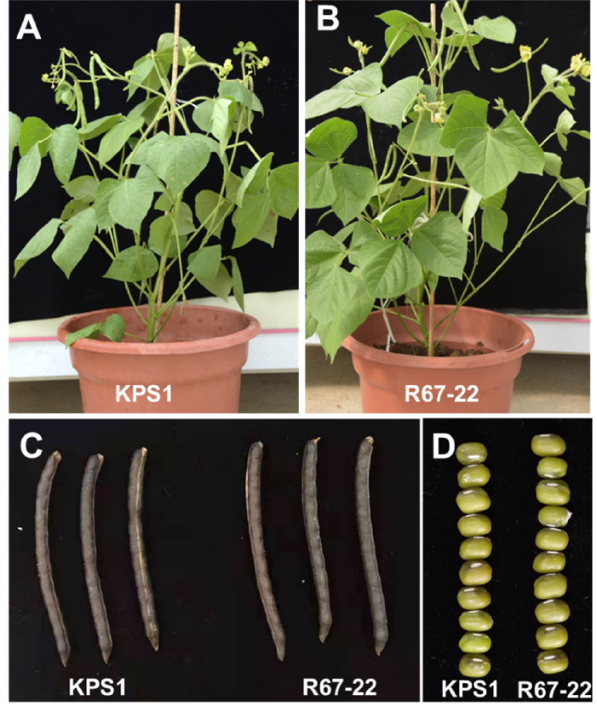
Figure 4. The plant phenotype and seed traits contrasted between R67-22 and KPS1. The comparison included the plant morphology of KPS1 ( A ), R67-22 ( B ), ripe pods ( C ), and mature seeds ( D ).